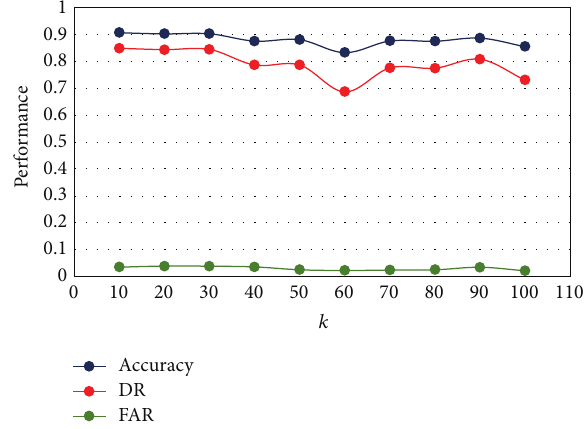
Figure 3: The performance of hybrid standard 𝐾 -means and